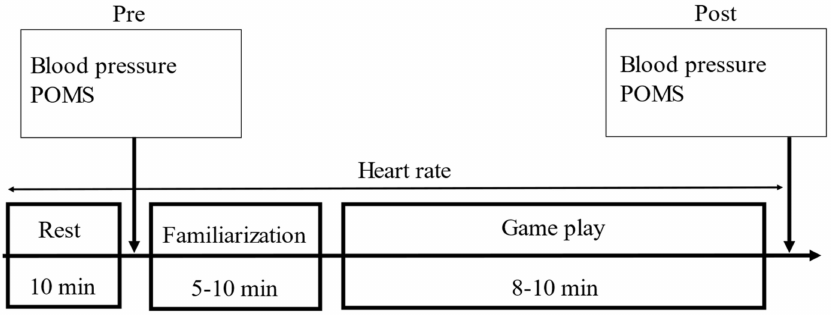
Figure 1. Study protocol.